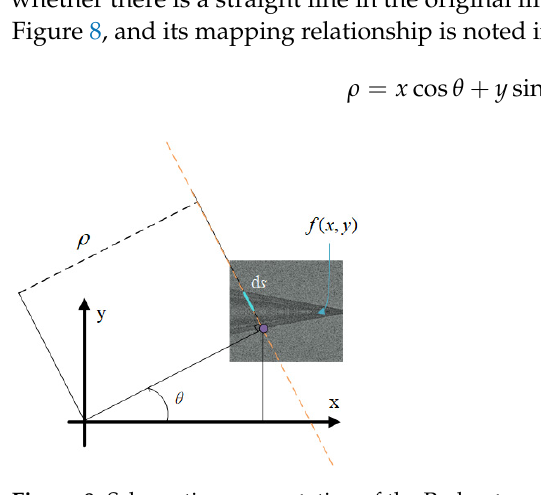
Figure 7. Simulated SAR image of ship wake in different polarization conditions. ( a ) wake model; ( b ) VV polarization; ( c ) HH polarization; ( d ) VH polarization.